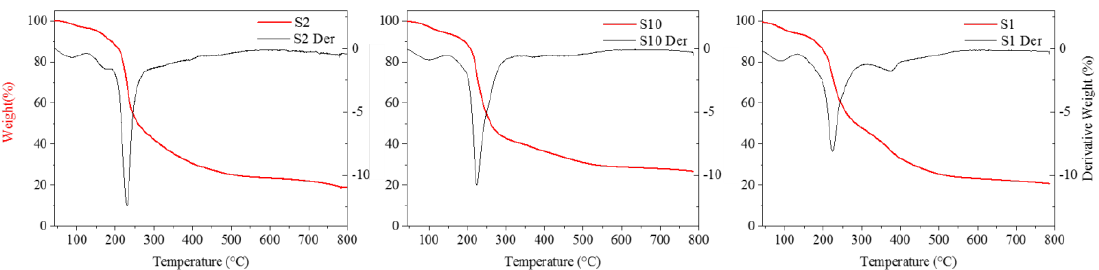
Figure 3. Representative thermo gravimetic analysis (TGA) spectra for pectin (S 2 ), alginate (S 10 ) and P/A/ WP (S 1 ) films.